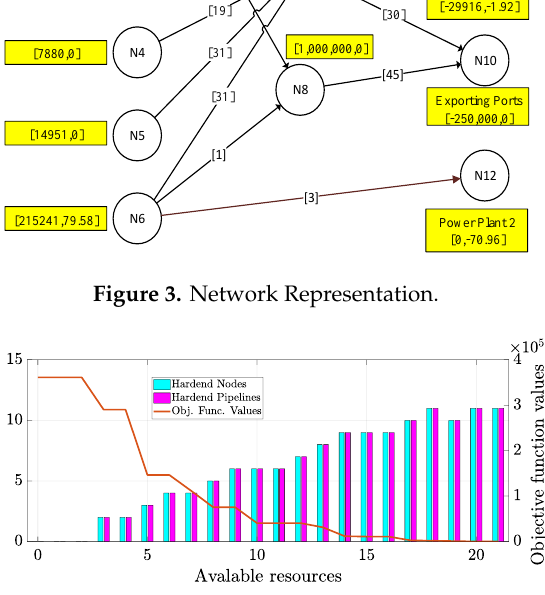
Figure 4. Model results verification: defender – attacker strategies without deception.